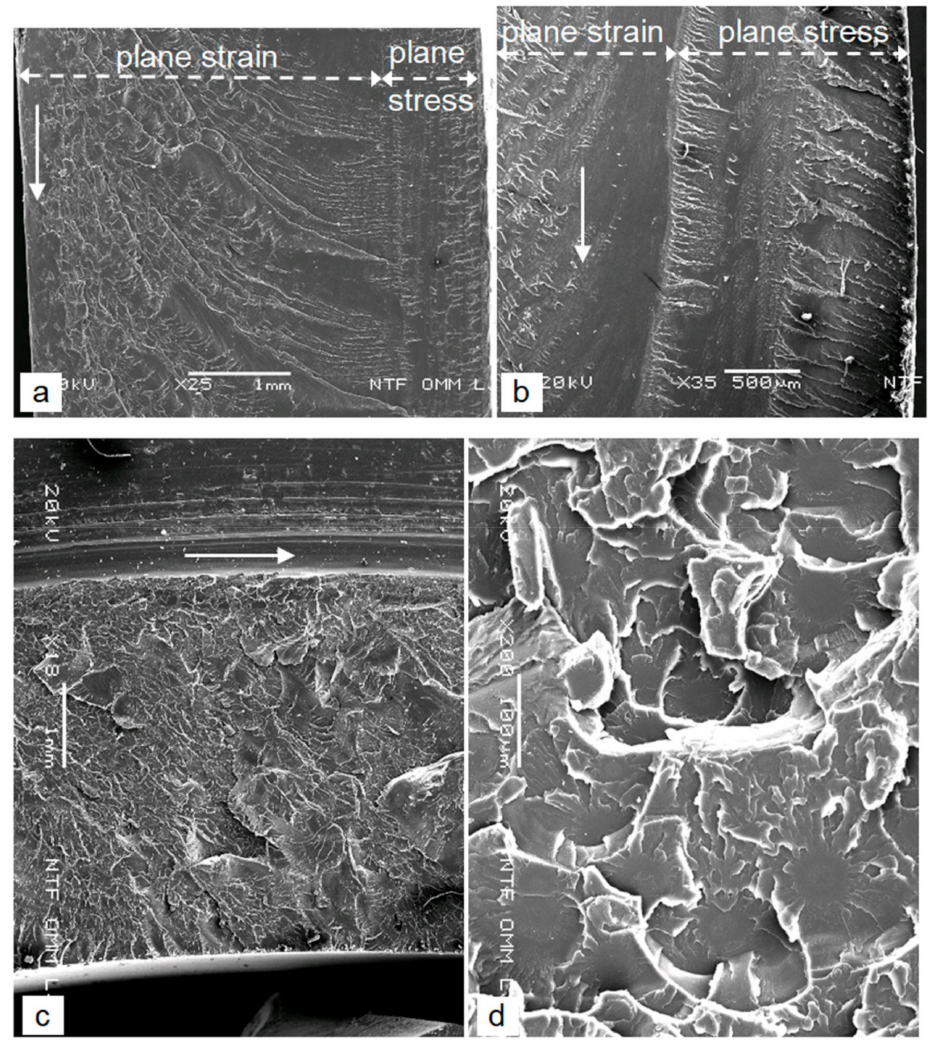
Figure 8. Crack surface texture of the area that is far away from the initial sites ( a ) curved hackle lines in the field of very rapid crack growth and the growth transition from the plane-strain to the plane-stress condition, the sample of series A [2] ( b ) the growth transition from the plane-strain to the plane-stress condition, horizontal crack in the curved part of the bottom of the sample of series C ( c ) slowly growing crack of the detached clamping ring, the sample of series D ( d ) the mixed brittle-ductile character of the crack surface with strong shear plastic tearing, the sample of series D; the solid arrows indicate the direction of the main crack